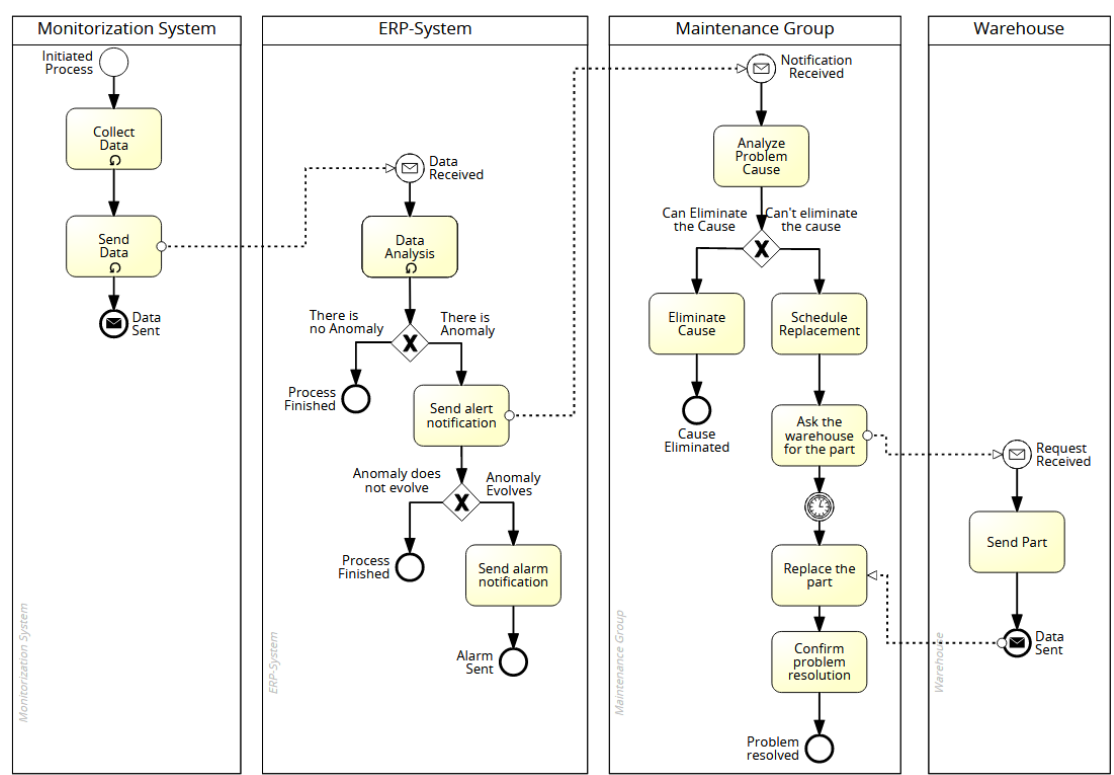
Figure A1. Preventive maintenance action plan.